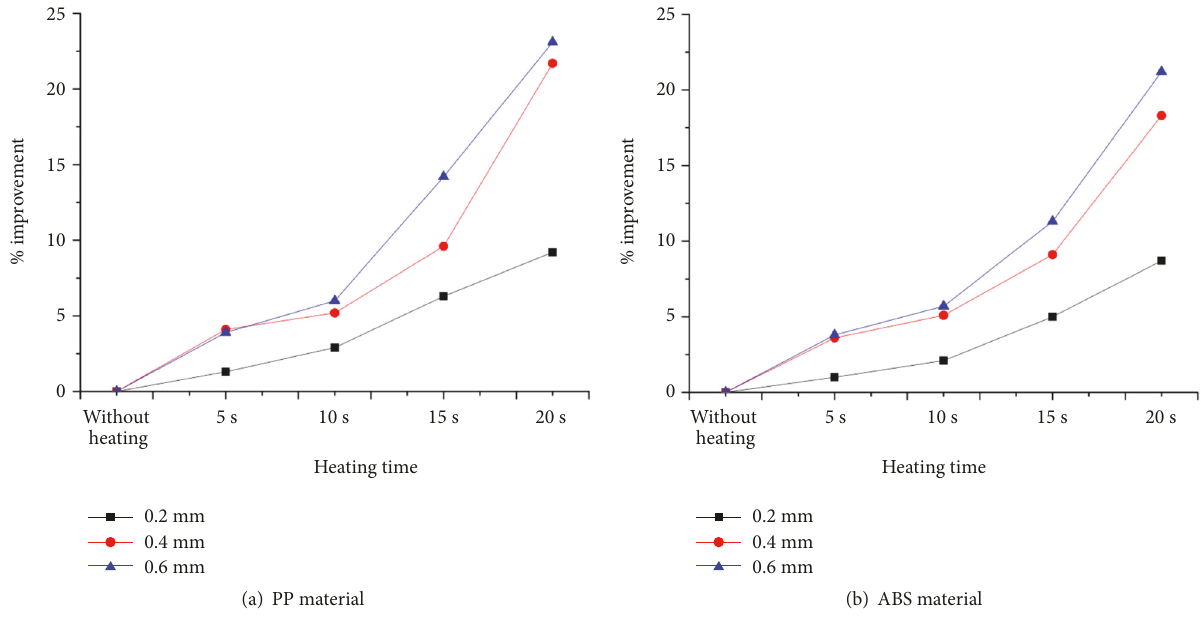
Figure 17: Improvement of melt flow length with the polypropylene and acrylonitrile butadiene styrene materials at different heating time.